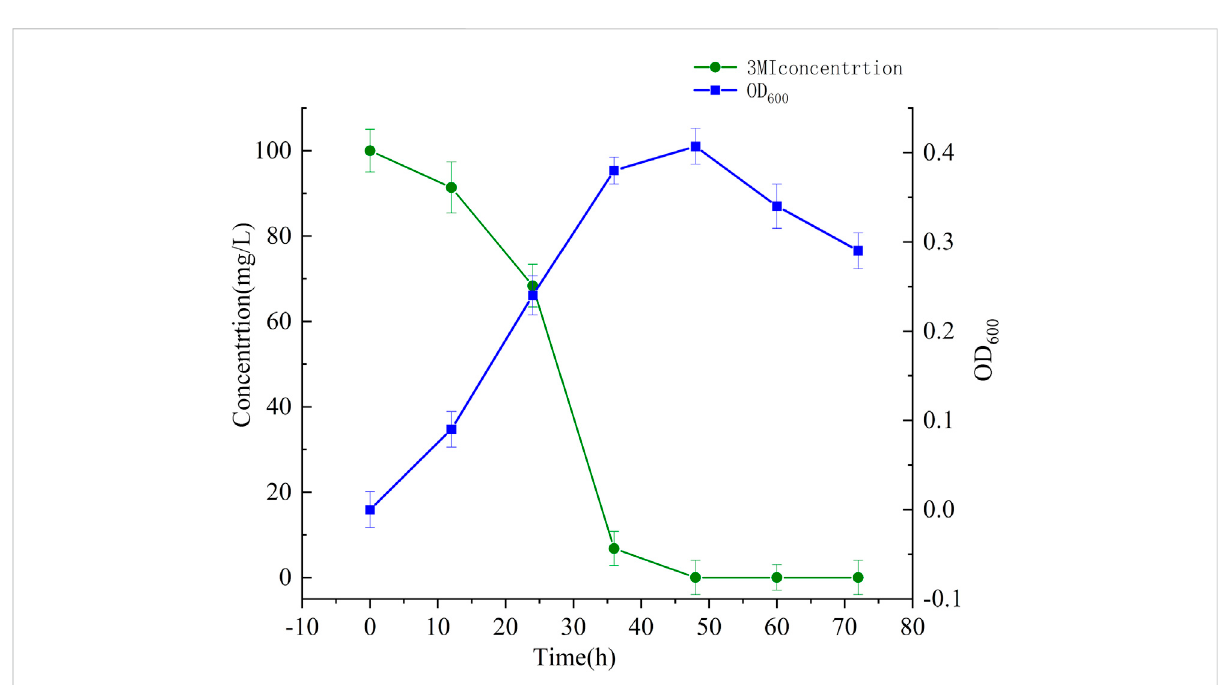
FIGURE 5 Growth and 3MI degradation activity for Acinetobacter oleivorans